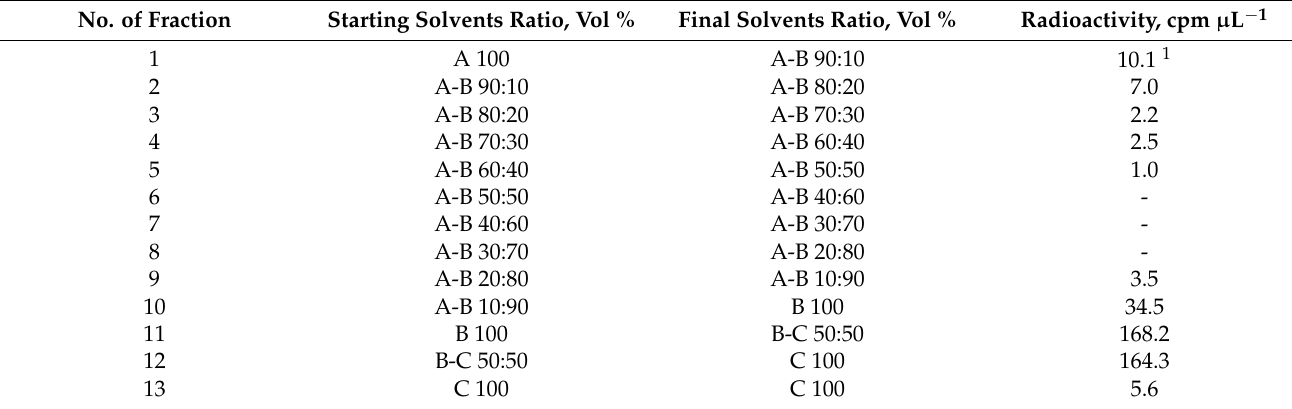
Table 1. Conditions for MPLC separation of metabolites and radioactivity of chromatographic fractions of the Rhodococcus sp. P1Y culture after incubation for 2 h in the presence of 3 H-labeled ABA. No. of